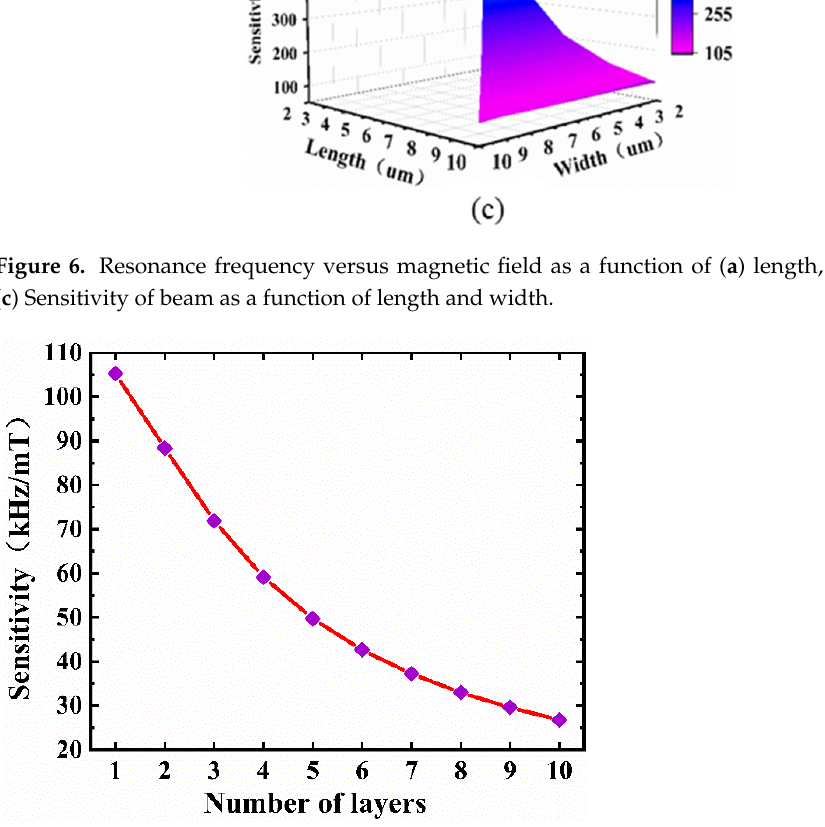
Figure 6. Resonance frequency versus magnetic field as a function of ( a ) length, and ( b ) width. ( c ) Sensitivity of beam as a function of length and width.